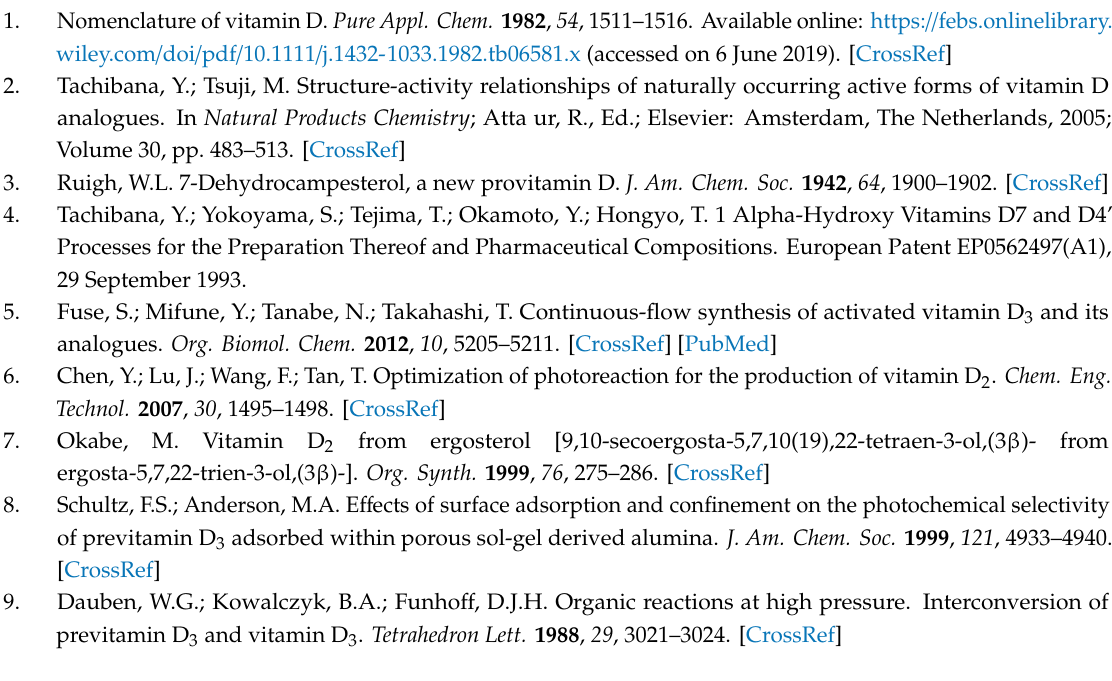
Figure S1: Synthesis of vitamin D 3 ; the experimental details on the synthesis of vitamin D 3 ( 13 ); Figures S2–S5: NMR spectra of vitamin D 2 ( 9 ); Figures S6–S9: NMR spectra of vitamin D 3 ( 13 ); Figures S10–S13: NMR spectra of vitamin D 4 ( 10 ); Figures S14–S17: NMR spectra of vitamin D 5 ( 6 ); Figures S18–S21: NMR spectra of vitamin D 6 ( 8 ); Figures S22–S25: NMR spectra of vitamin D 7 ( 7